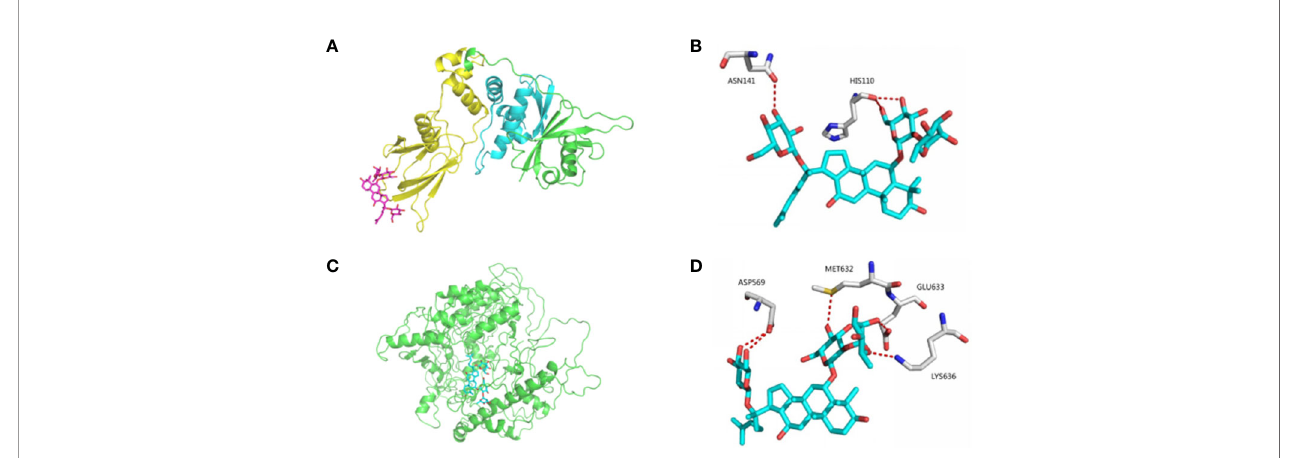
FIGURE 3 | The bindings among ginsenoside Re, VHL protein and HIF-1 a protein. (A, B) The details of predicted binding mode of ginsenoside Re and VHL protein. The contact residues were shown and labeled by type and number. The red dotted line illustrated the hydrogen bond interaction. (C, D) The details of predicted binding mode of ginsenoside Re and HIF-1 a protein. The contact residues were shown and labeled by type and number. The red dotted line illustrated the hydrogen bond